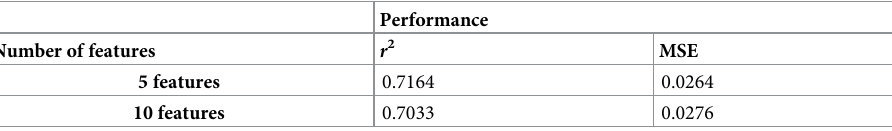
Table 15. Performance of two chosen SVR